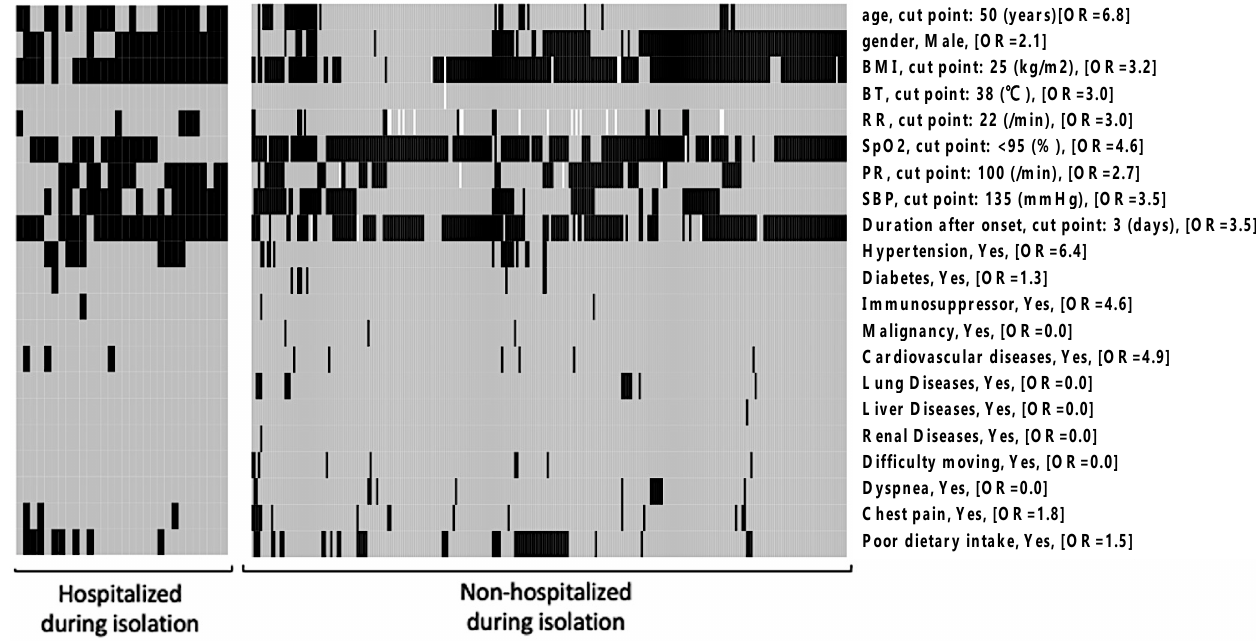
Figure 2. Heatmap of each variable in the COVID-19 outpatient triage: Patients hospitalized at ED visit ( n = 30) and those without hospitalization during isolation ( n = 272) were grouped. Black-filled patients represent values over cutoff values (for continuous variables) or the presence of underlying diseases or symptoms. Gray-filled patients represent values lower than the cutoff values (for continuous variables) or the absence of underlying diseases or symptoms. White-filled patients represent missing data. The cutoff values were defined using the Youden index. In the brackets, ORs for the association between the variable ( ≤ median, >median) and the occurrence of “Hospitalized at ED visit” are mentioned. Abbreviations: BMI, body mass index; BT, body temperature; ED, emergency department; OR, odds ratio; PR, pulse rate; RR, respiratory rate; SBP, systolic blood pressure.